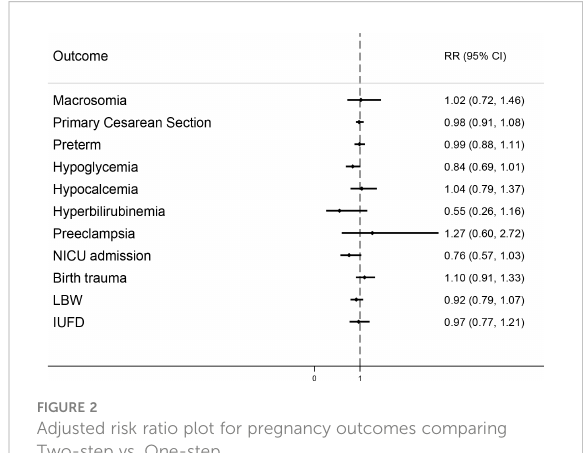
FIGURE 2 Adjusted risk ratio plot for pregnancy outcomes comparing Two-step vs.